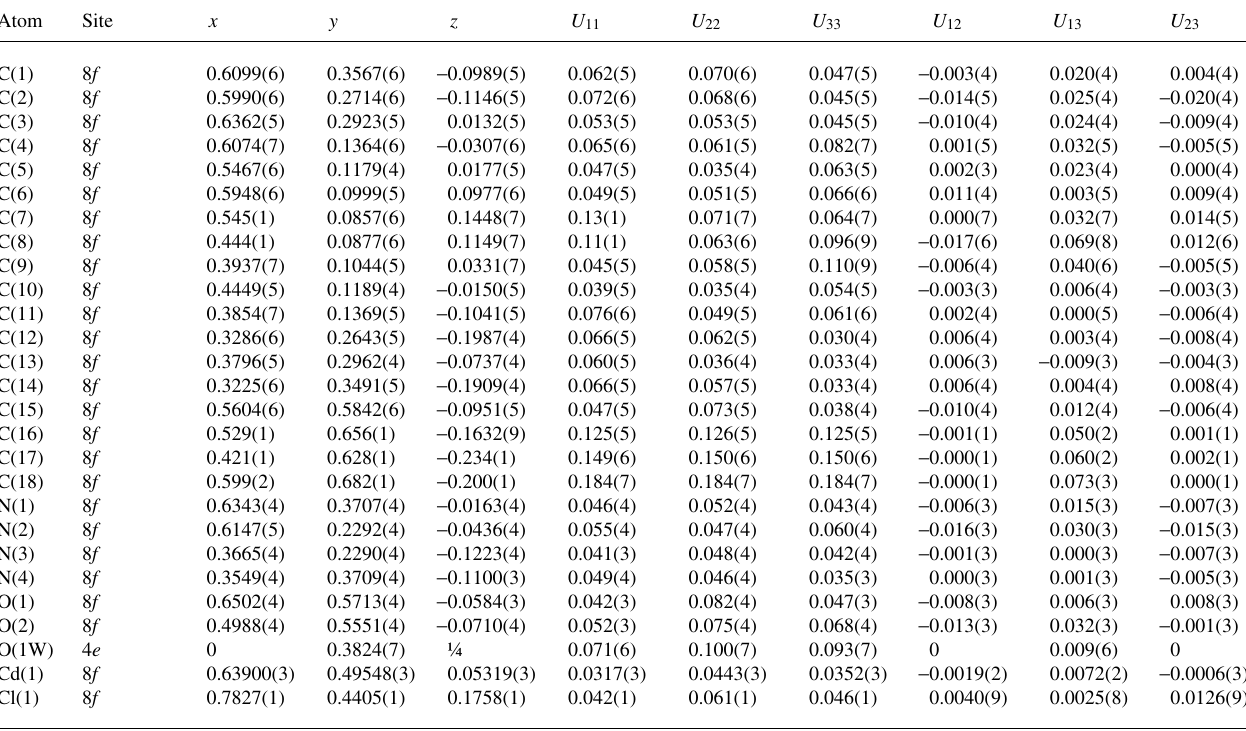
Table 3. Atomic coordinates and displacement parameters (in Å 2 )